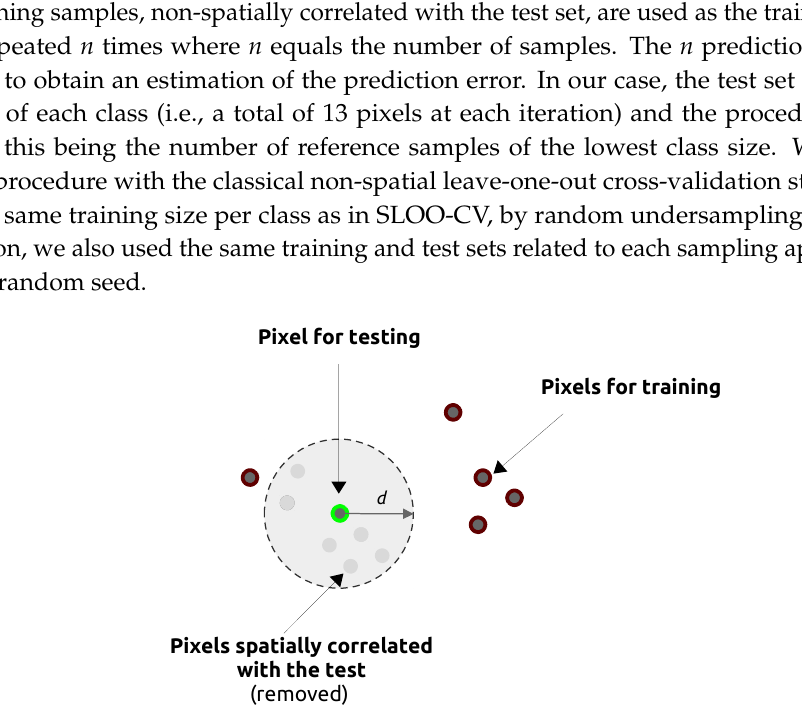
Figure 4. Spatial leave-one-out cross-validation (SLOO-CV) schema for one class. One pixel is used for testing. The other pixels are used for training, except pixels geographically too close to the pixel selected for testing. This procedure is repeated n times where n is the number of reference samples. Spatial autocorrelation between nearby pixels is assumed up to a distance d which can be estimated using Moran’s